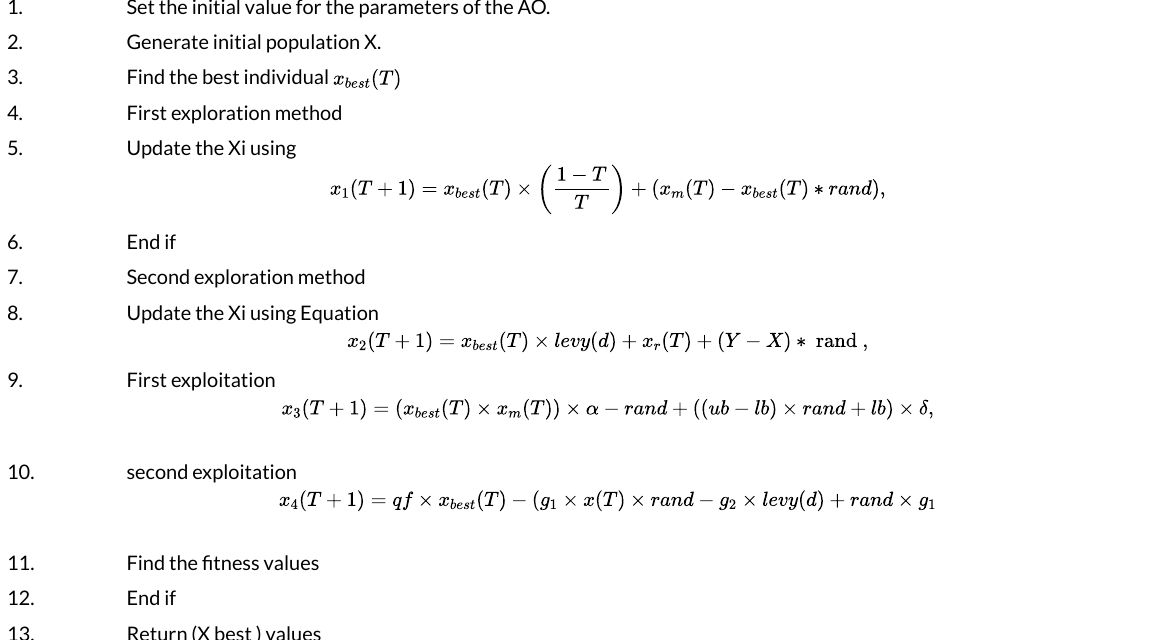
Algorithm 1. Cluster formation using improved Aquila